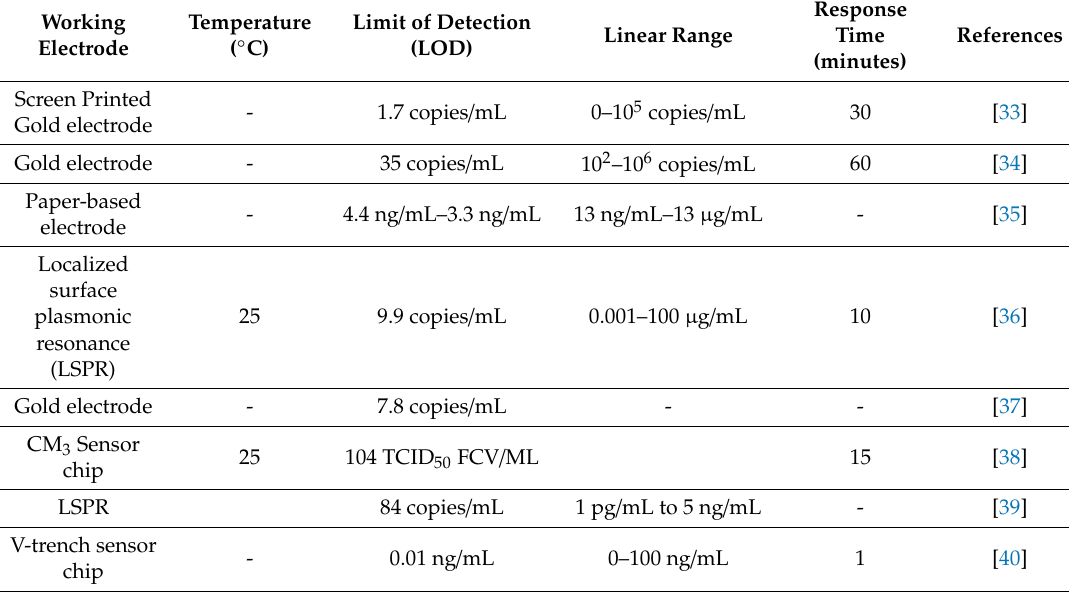
Table 1. Comparison of various biosensors integrated with di ff erent types of electrodes used for norovirus detection.